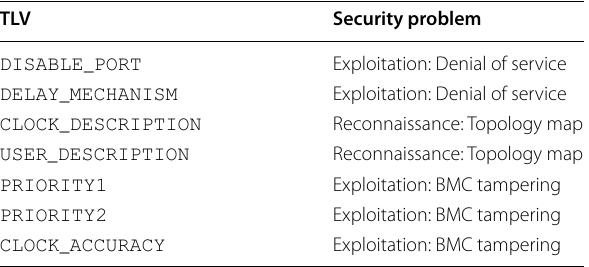
Table 1 Exploited TLVs, details on attacks possible with these TLVs are presented in Sect.